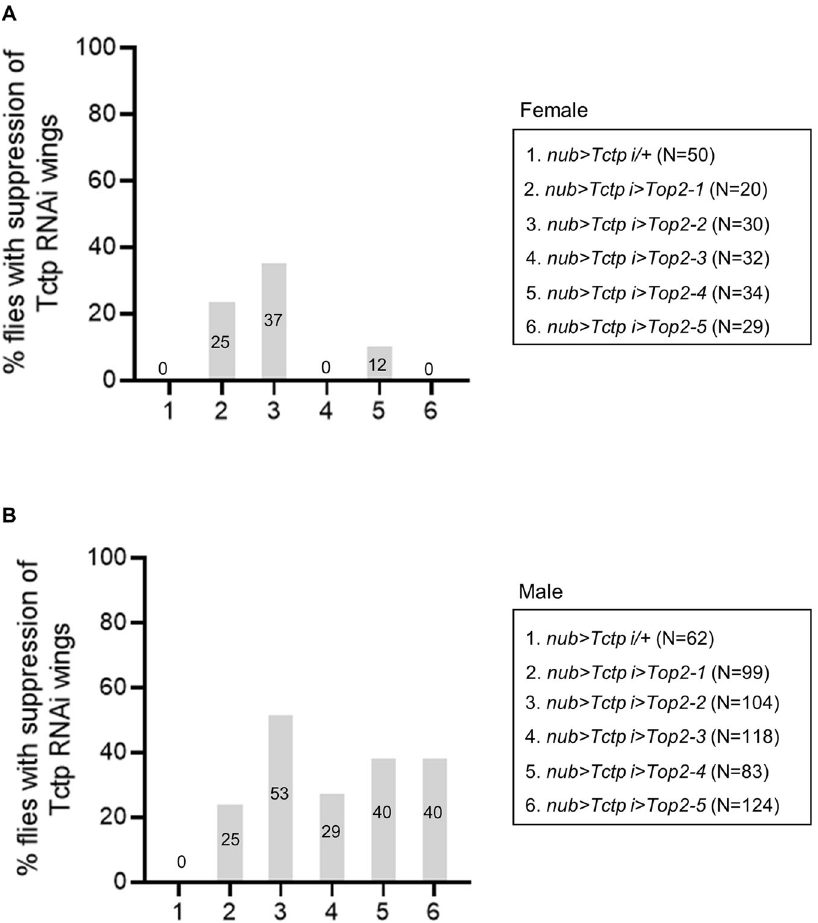
Fig. 6 Overexpression of Top2 can partially suppress the Tctp RNAi phenotype. A , B Genetic interaction between Tctp RNAi and Top2 overexpression by UAS-Top2 lines ( UAS-Top2-1 to UAS-Top2-5 ). A Females. Control progeny ( nub > Tctp i/ + ) from a cross between nub > Tctp RNAi and w 1118 fl ies shows 100% wing defects with no suppression. Tctp RNAi phenotypes are suppressed by Top2 overexpression from three out of fi ve UAS-Top2 lines (lines 2, 3, and 5) ( B ) Males. Control progeny ( nub > Tctp i/ + ) shows 100% wing defects with no suppression. Tctp RNAi phenotypes are suppressed by Top2 overexpression from all fi ve UAS-Top2 lines. N number of animals. Numbers in the bars indicate % adults showing the